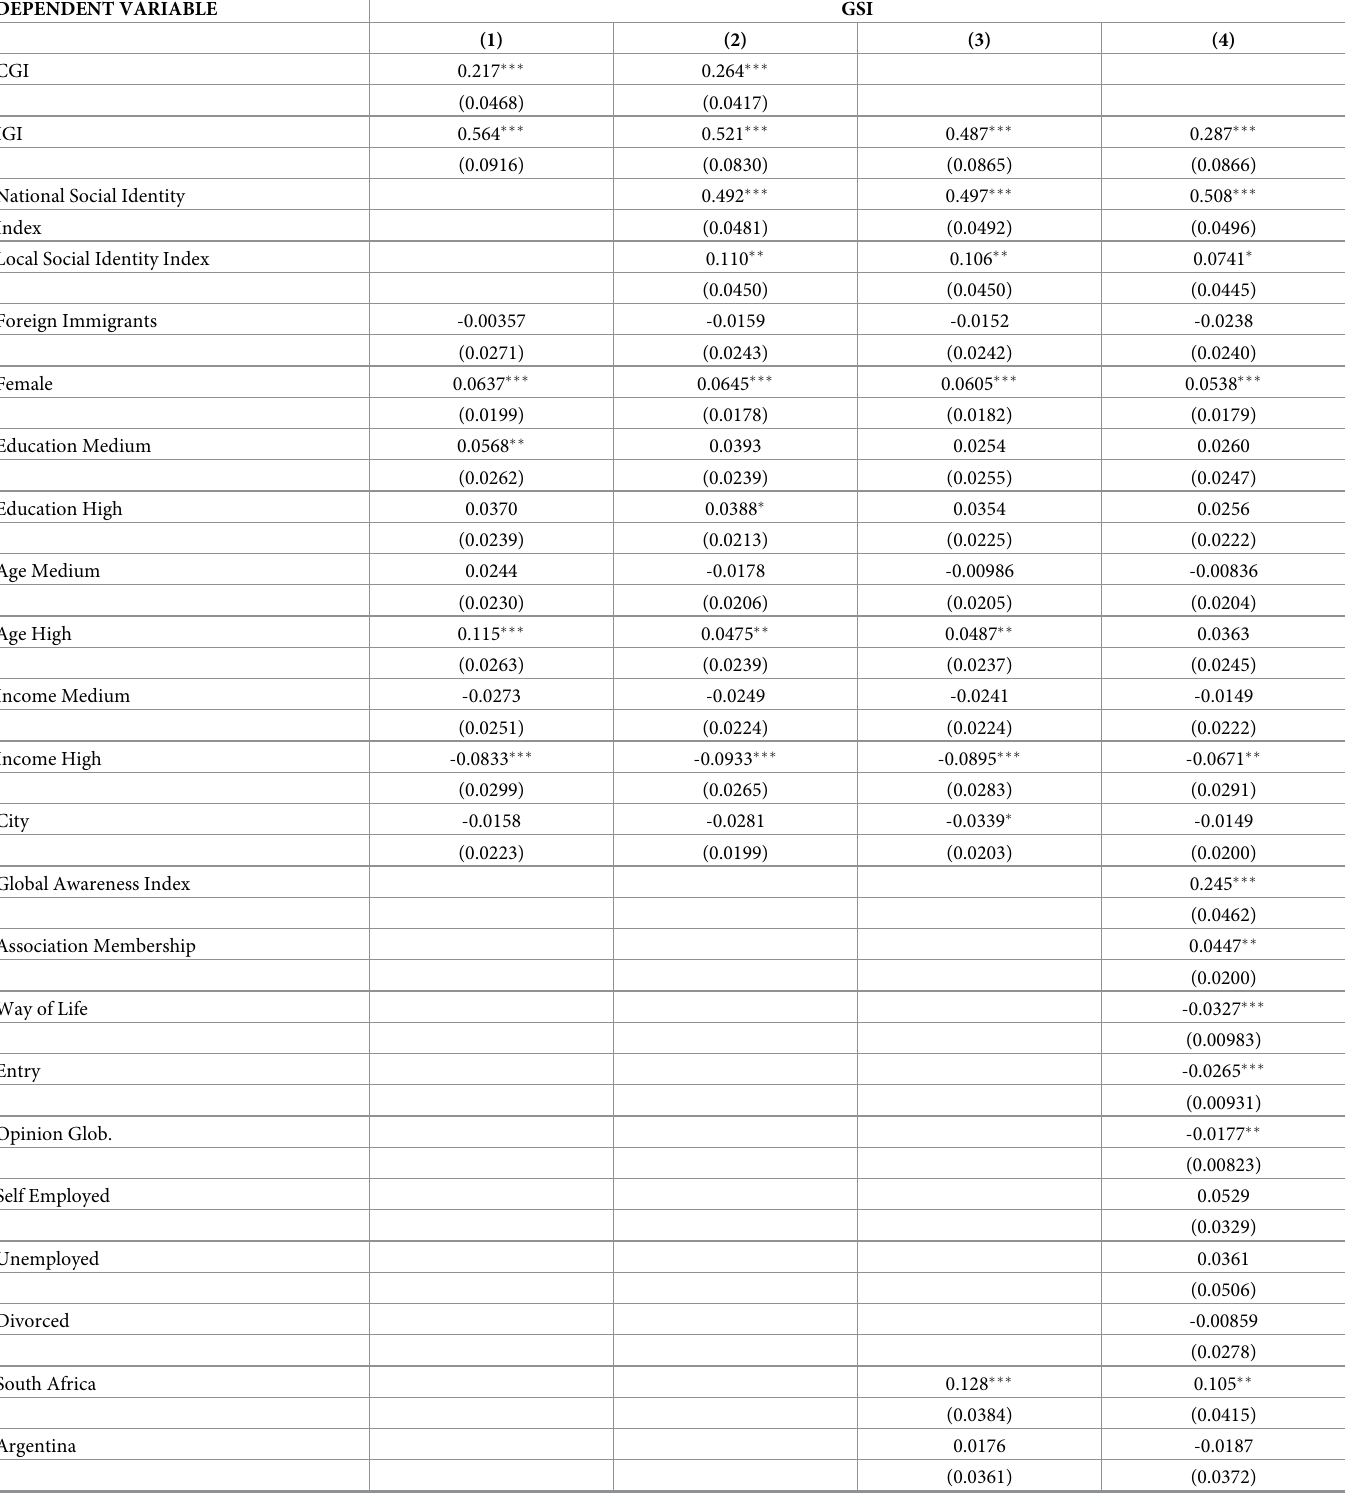
Table 1. Regression analysis of factors associated with